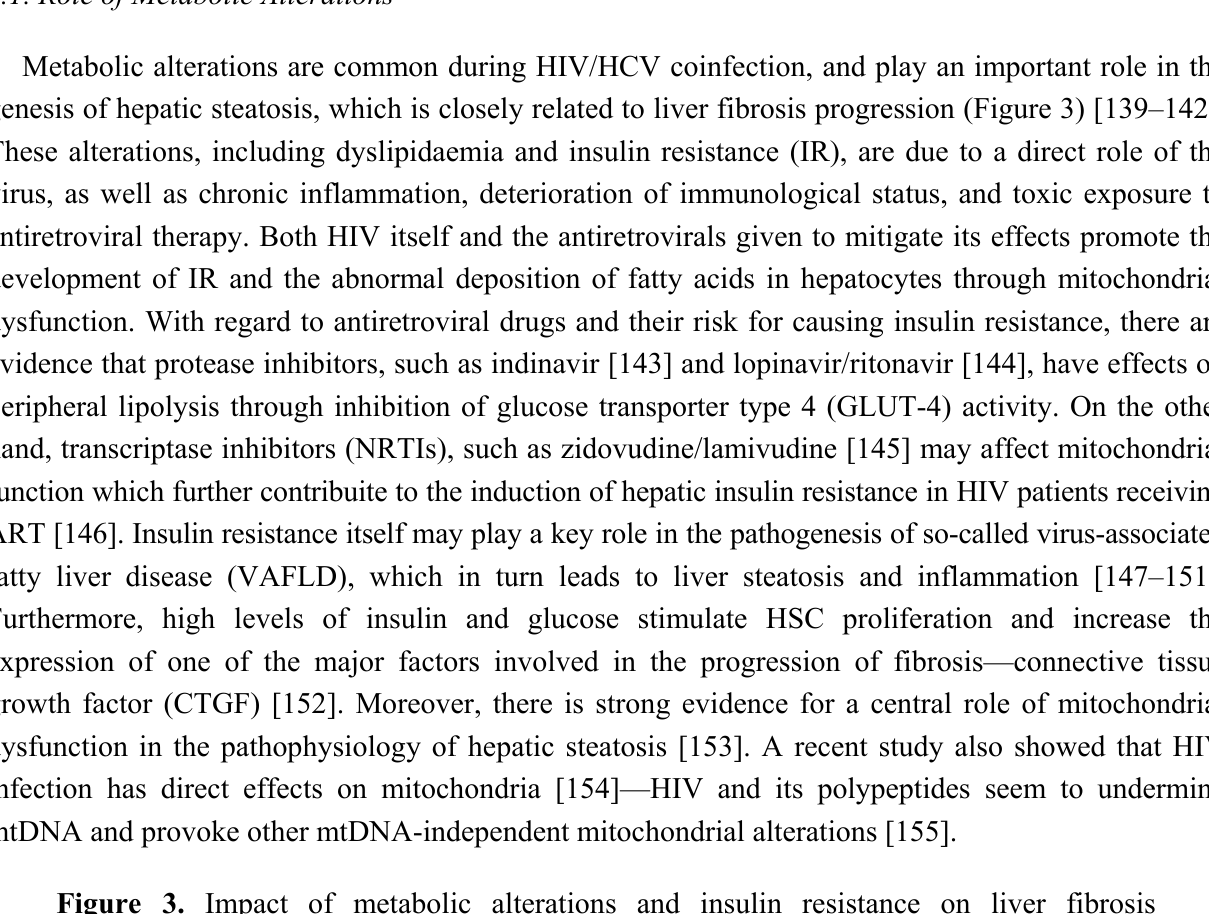
Figure 3. Impact of metabolic alterations and insulin resistance on liver fibrosis progression. Interplay between HIV/HCV coinfection, toxic effects of antiretroviral drugs, and chronic inflammation may play a critical role in the development of hepatic steatosis and fibrosis